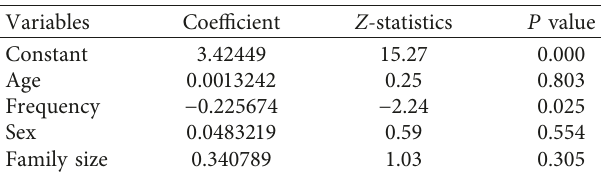
Table 7: Estimation results of the Log-normal